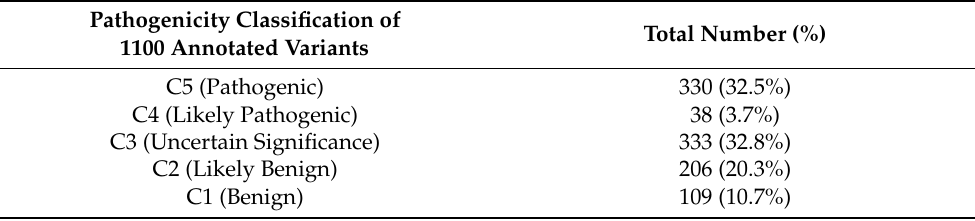
Table 2. Summary of classified variants included in iVar. Pathogenicity Classification